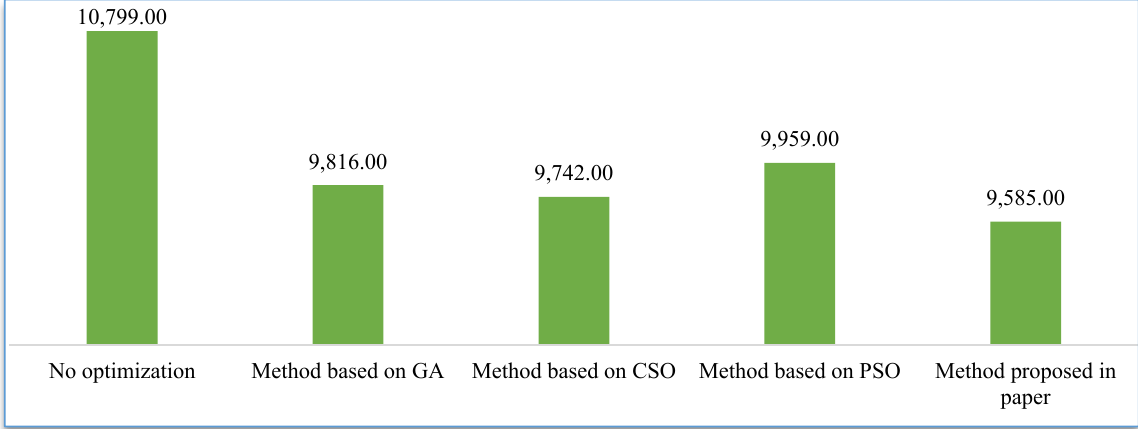
Figure 5. Running distance and tractive force.